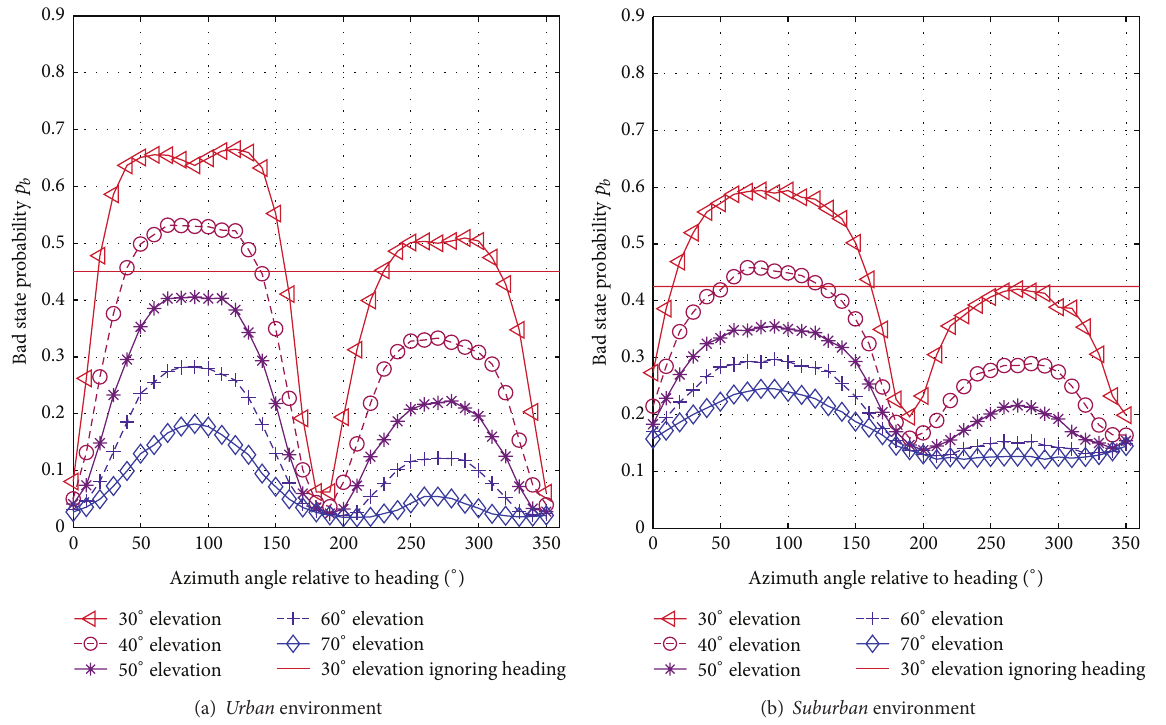
Figure 10: The bad state probability (service unavailability) for urban (a) and suburban (b) environment. The dependency on the azimuth angle (relative to driving direction) is shown for satellites at different elevation angles. For an elevation of 30 ∘ also the result of ignoring the heading is plotted as a constant (red line).